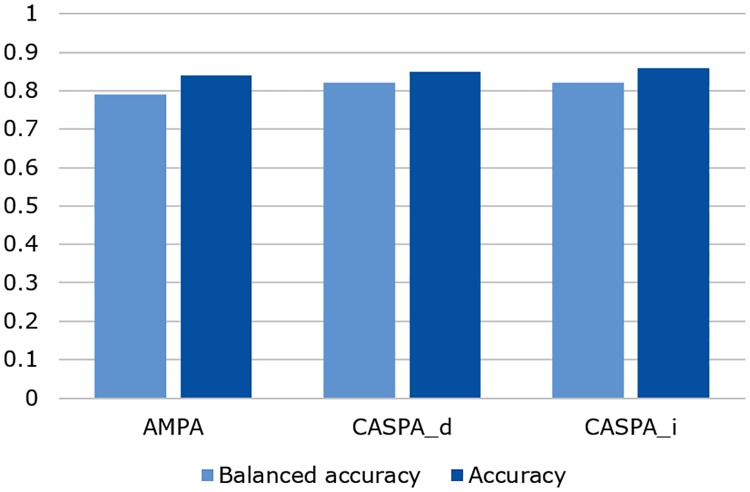
Key results of the evaluation study.Accuracy and balanced accuracy (see Eq 12) measure the congruence of algorithmic (AMPA, CASPAd, CASPAi) and human experts’ assessments.